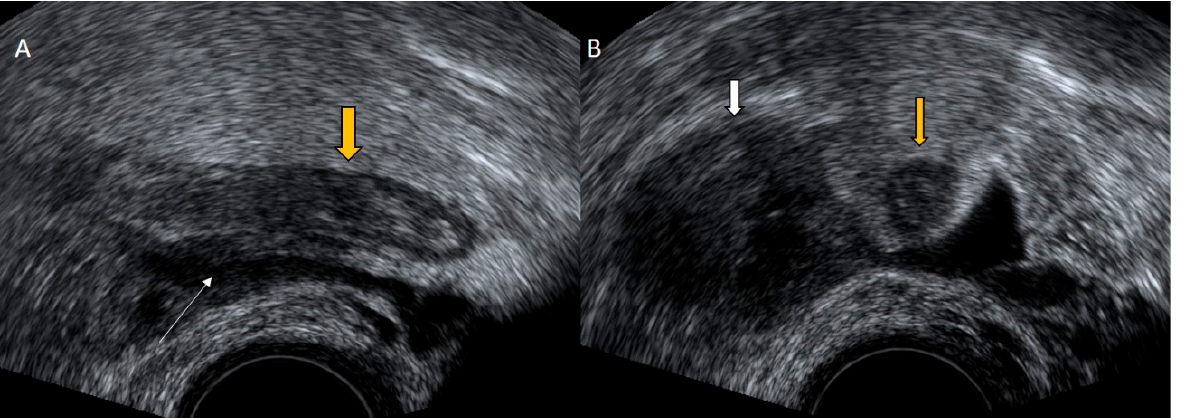
Figure 1. Grayscale transvaginal ultrasound of an inflamed appendix. Longitudinal transvaginal sonographic image demonstrates a blind-ending tubular structure in the right adnexal region pointed with yellow arrow and a small periappendiceal fluid collection (white arrow) ( A ). Transverse sonographic view showing the right ovary (white arrow) and the characteristic submucosal ring of an inflamed appendix (yellow arrow) ( B ).